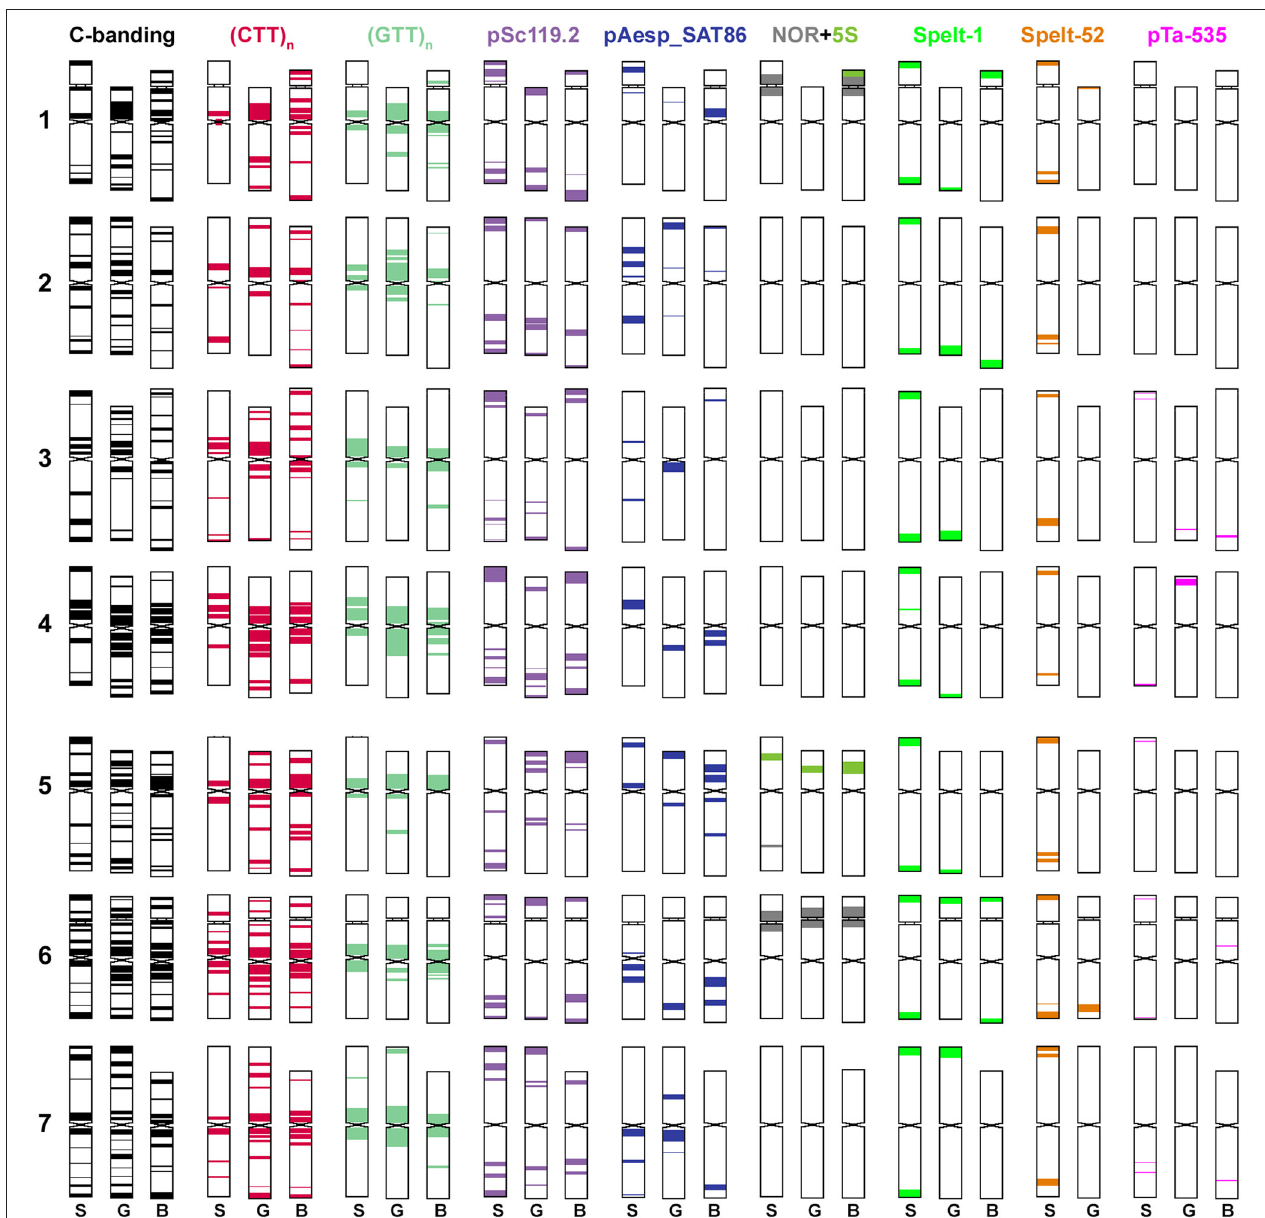
FIGURE 2 | Idiogram showing relative positions of C-bands and nine DNA probes (probe names are given on the top) on chromosomes of Ae. speltoides (S), the B-genome (B) of common wheat and G-genome (G) of T. timopheevii .